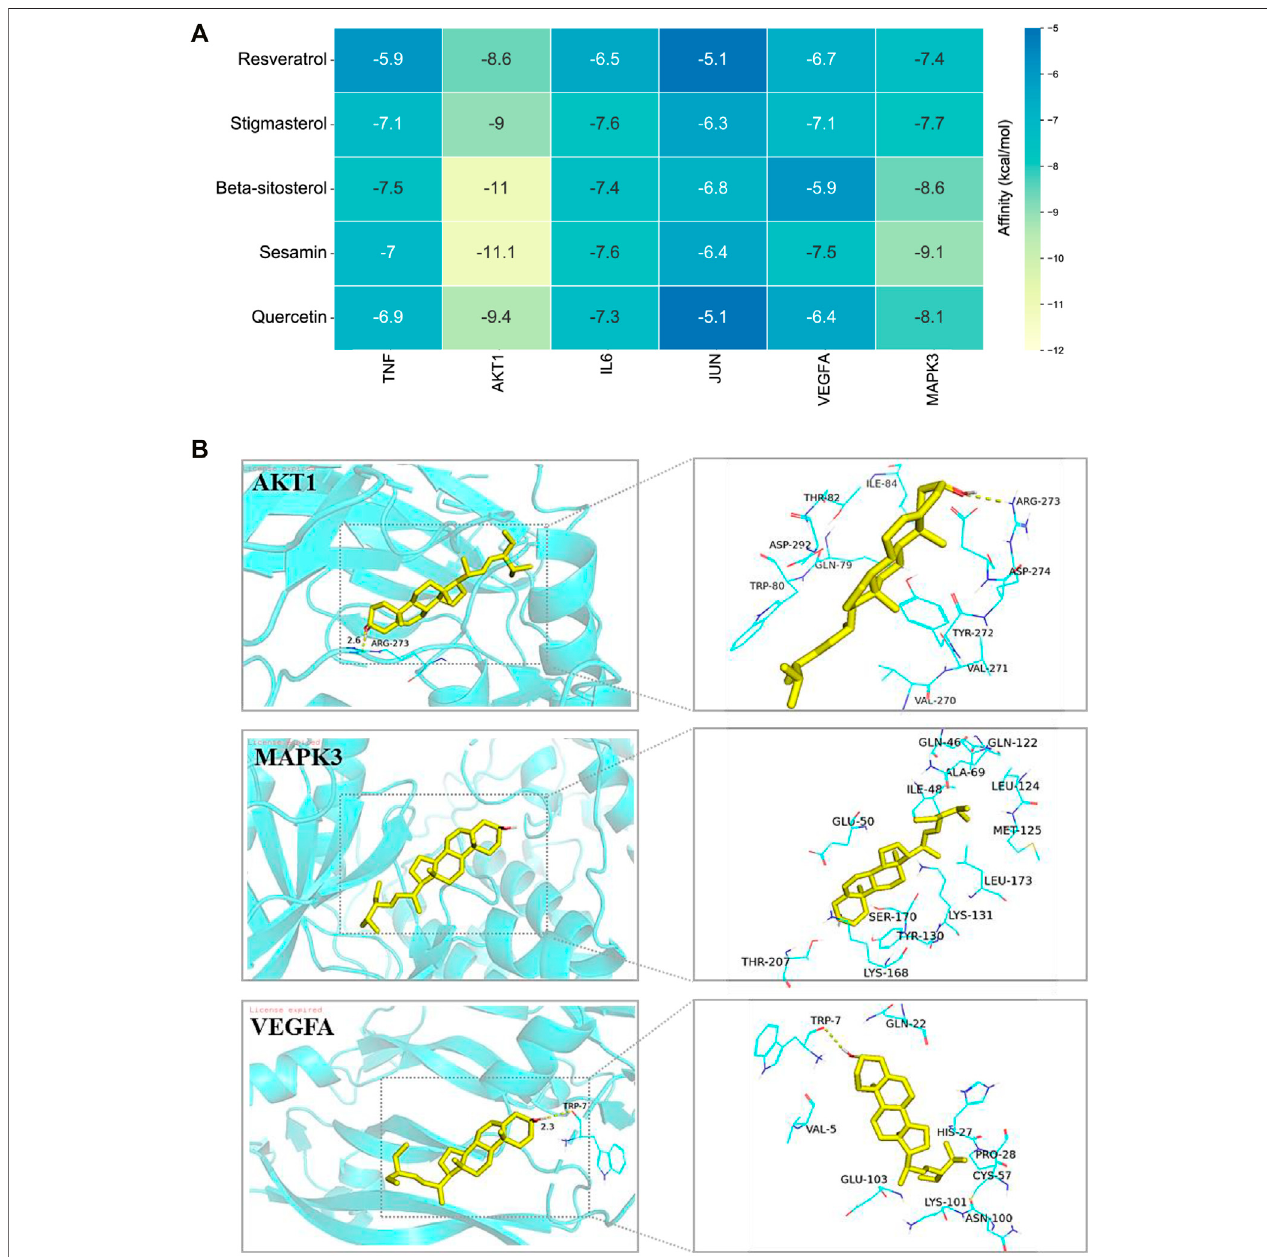
FIGURE6| Moleculardockingstudyofthebindingofhubtargetspredictedbynetworkpharmacology. (A) ThedockingscoreofcorelingredientsofFLKMwiththe sixhubtargetproteins. (B) ThedockingofAKT1,MAPK3,andVEGFAandstigmasterol.Allpicturesshowthe3Ddockingofligandsintheactivebindingpocket,withthe hydrophobic effect area and the 2D interaction patterns between the ligands and proteins and the important interactions between the ligand atoms and amino acid residues of the proteins being displayed.